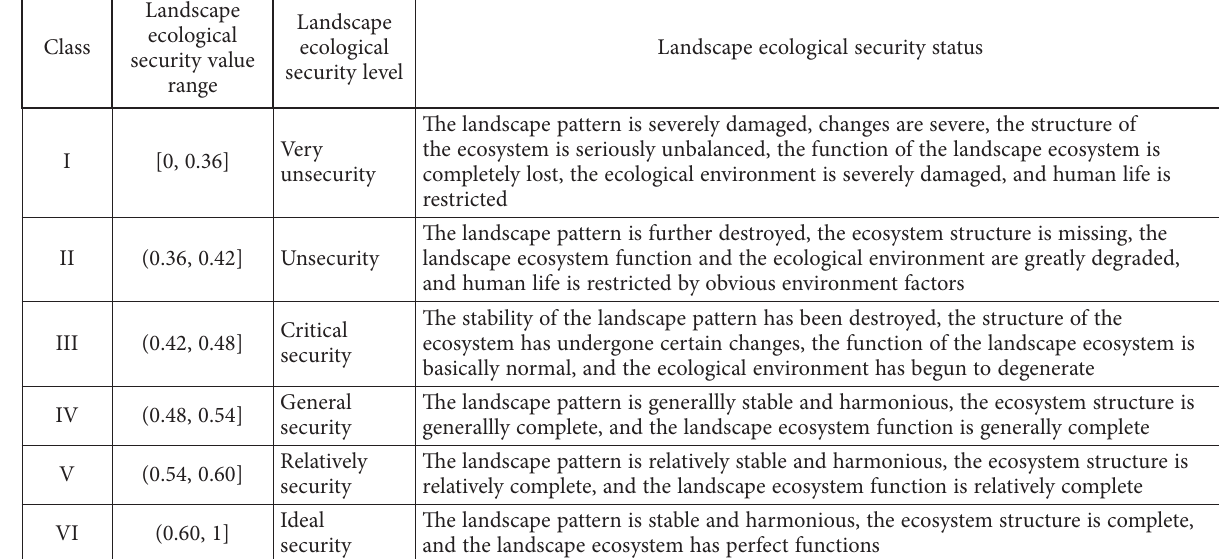
Table 4. The class level of landscape ecological security evaluation